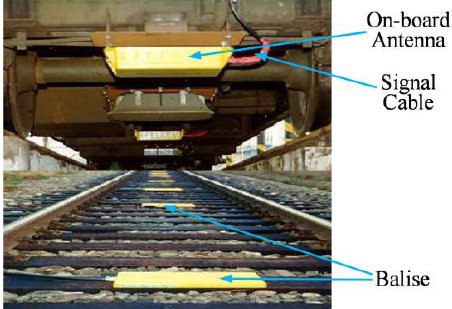
Figure 1. Balise-Based Train Positioning Structure.